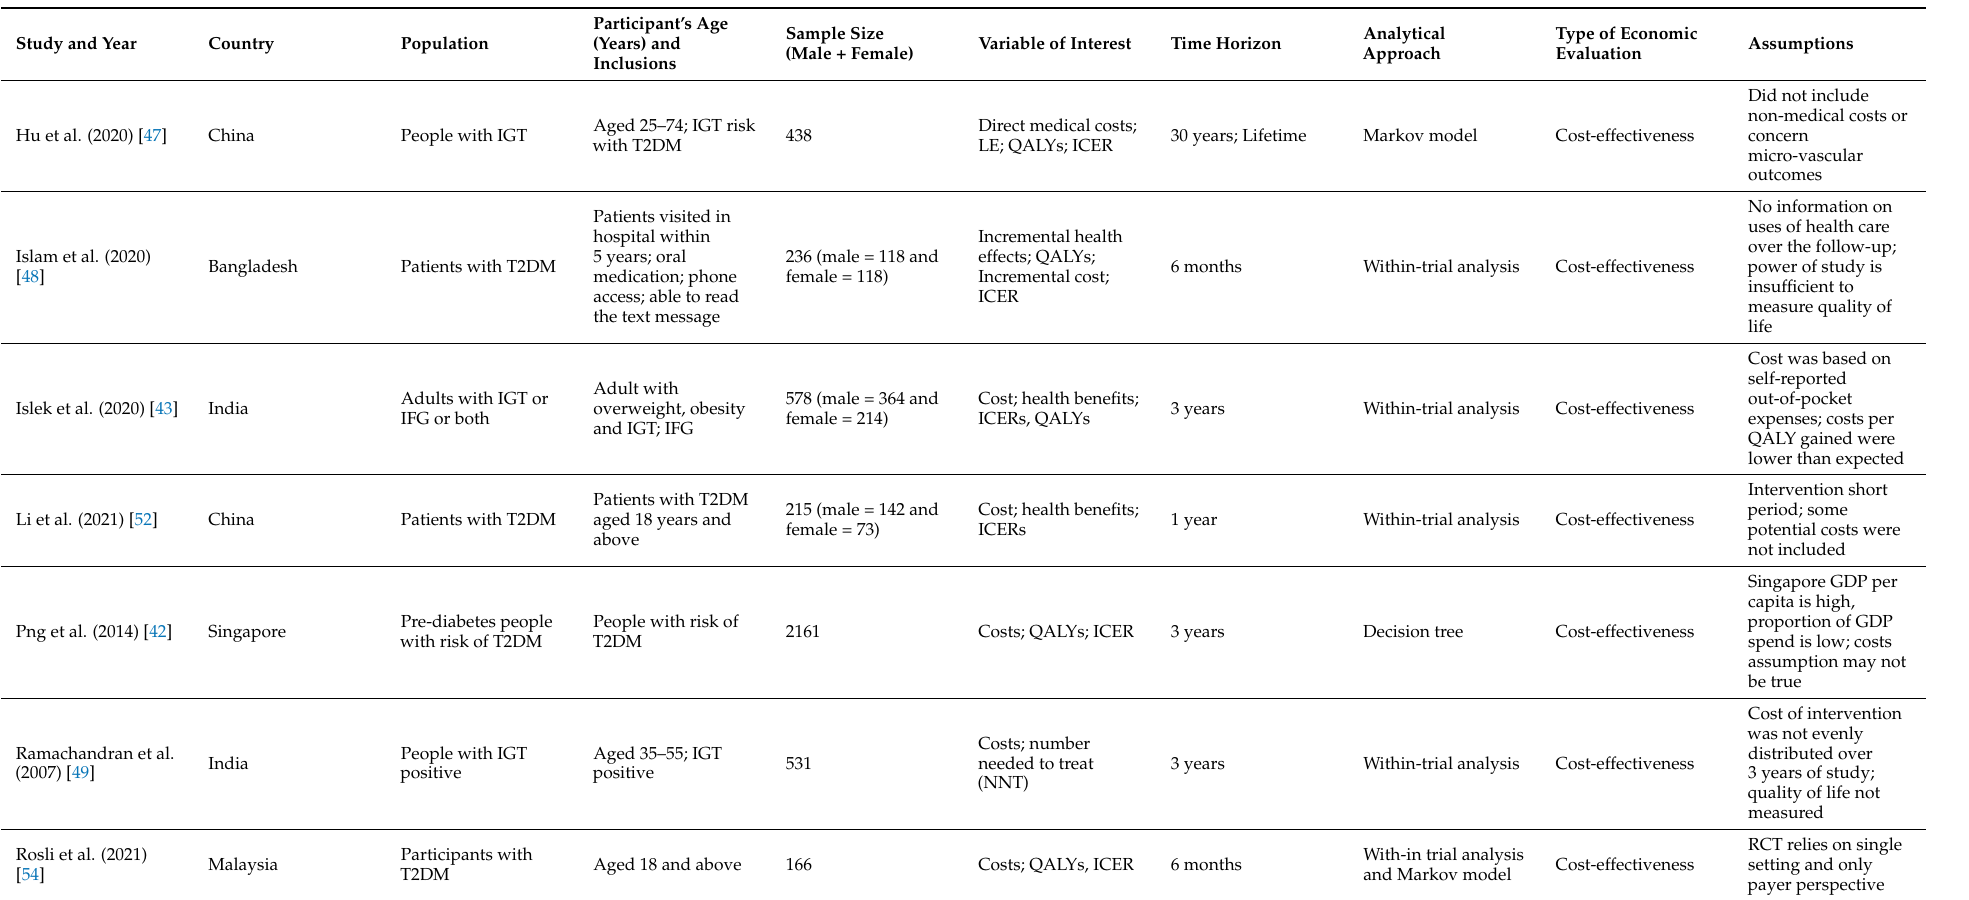
Table 2. General characteristics of the selected